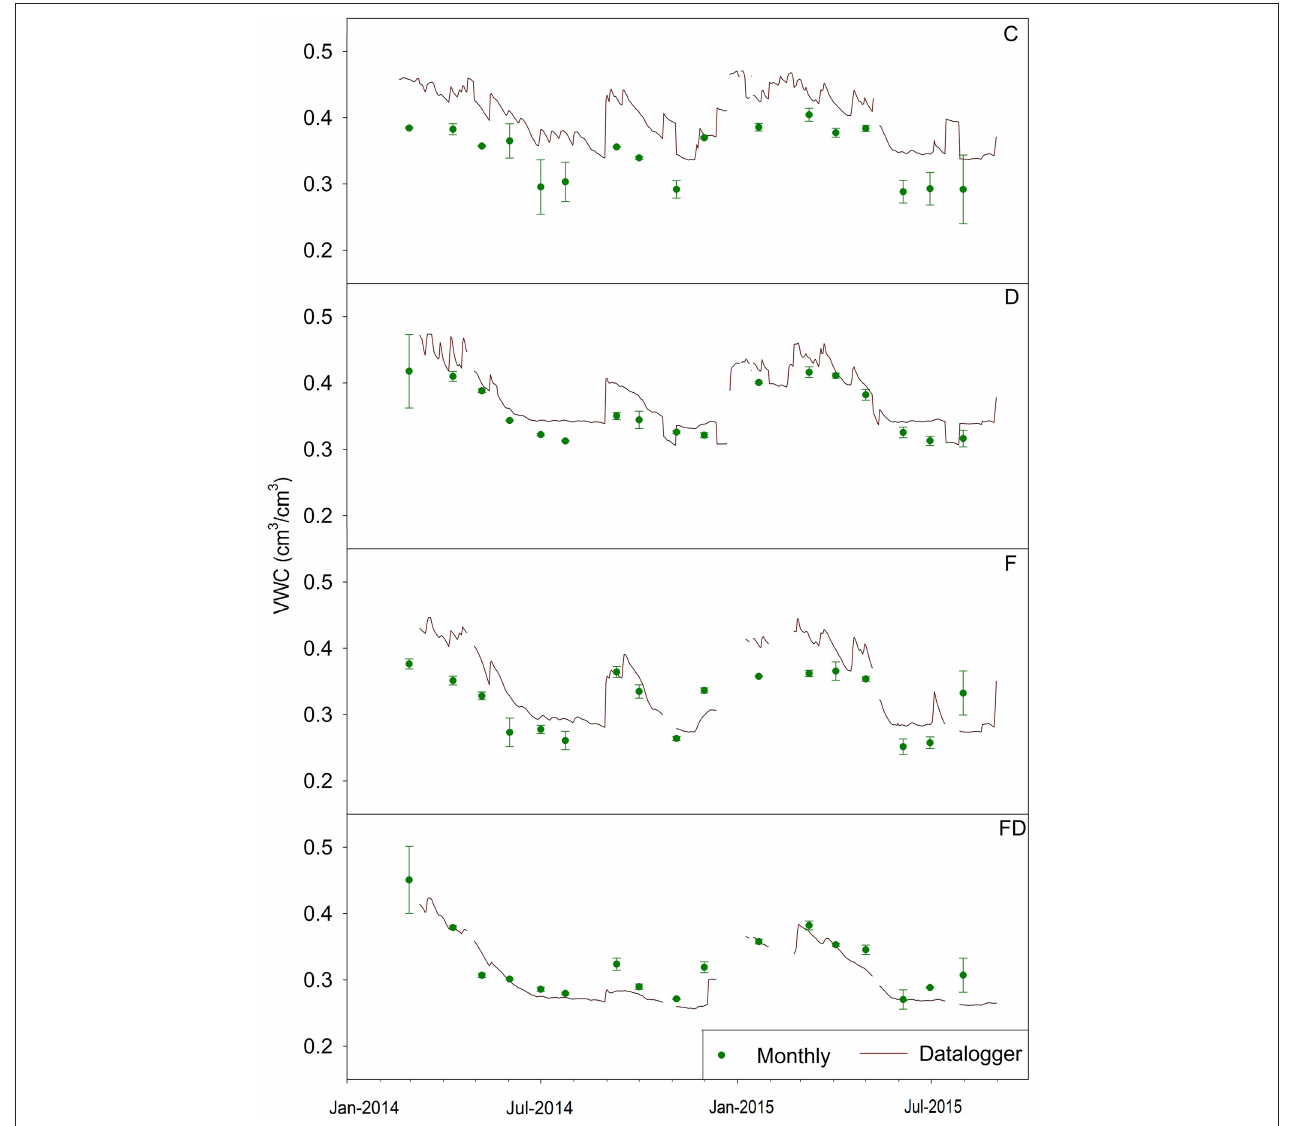
FIGURE 9 | Average daily soil volumetric water content (VWC) at 0.6m based on 30-min readings of soil moisture probes (red line) and monthly point samples of VWC (mean ± 1 SE) ( n = 4). Treatments are control (C), fertilization (F), throughfall reduction (D), and combined treatment of